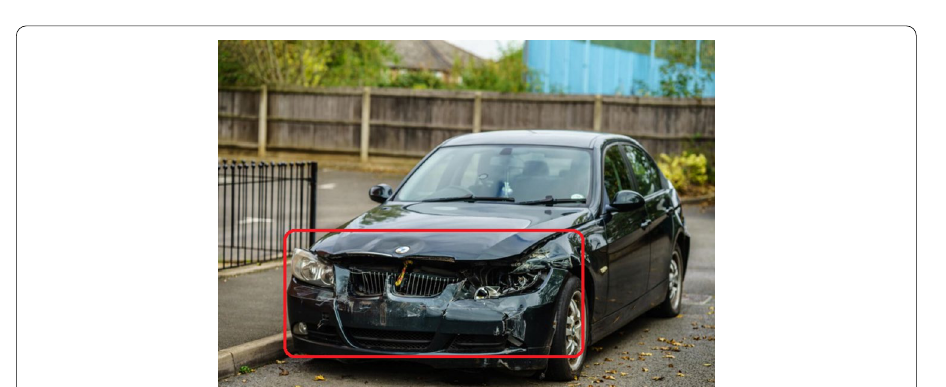
Fig. 4 First example of areas damage detection